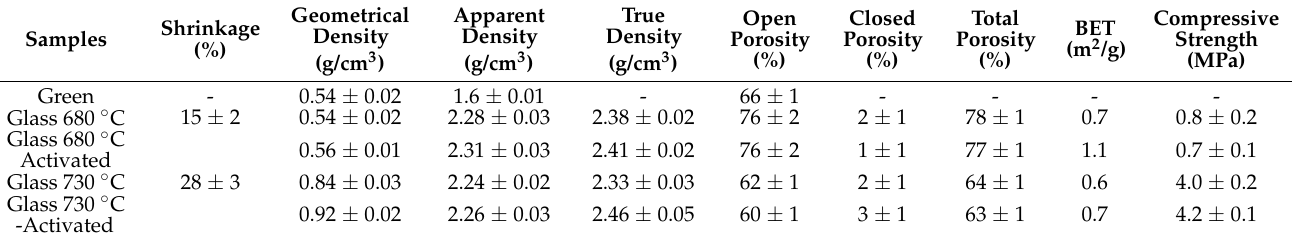
Figure 1. ( a ) Reference three-dimensional gyroid model; ( b ) printed gyroid before debinding and sintering; ( c ) gyroid after firing at 680 °C; ( d ) gyroid after firing at 730 °C. Table 1. Physical and mechanical properties of activated and non-activated gyroids.